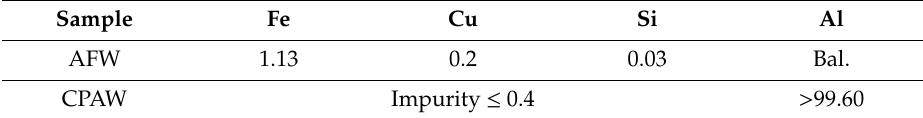
Table 1. Chemical composition of commercially pure Al wires (CPAW) and Al-Fe wire (AFW). Sample Fe Cu Si Al AFW 1.13 0.2 0.03 Bal. CPAW Impurity ≤ 0.4 >